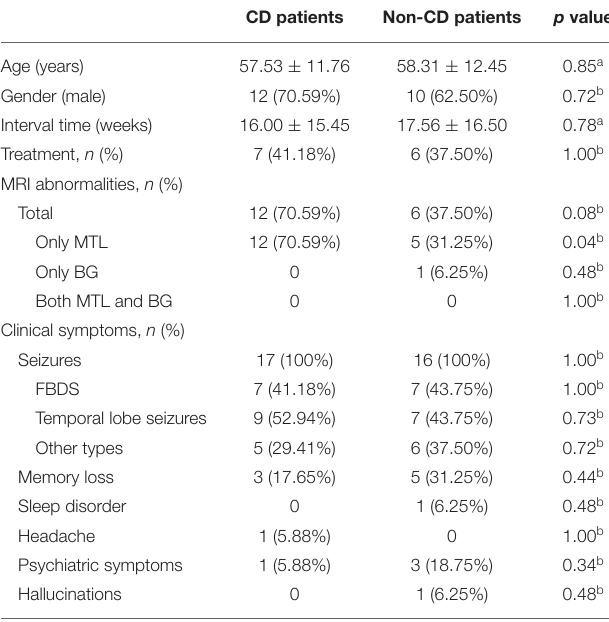
TABLE 2 | Comparison of clinical characteristics between CD patients of the training cohort and non-CD patients of the testing cohort. CD